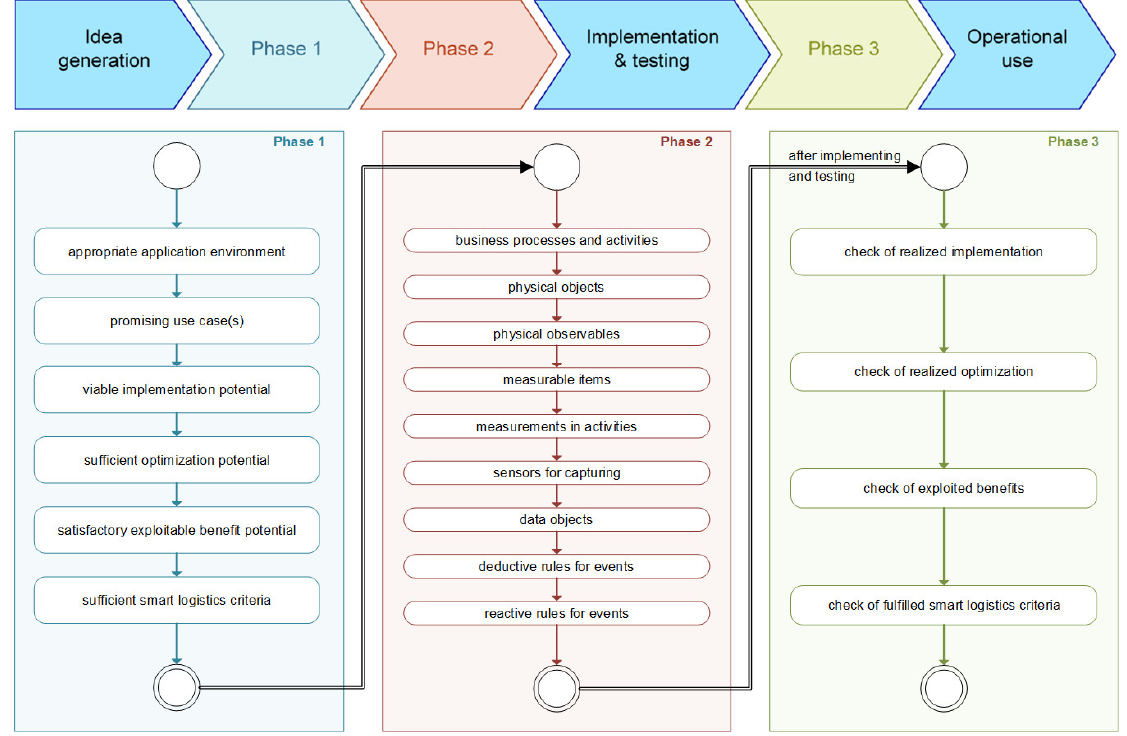
Figure 1. Methodology of realizing smart logistics processes with the help of Cyber-Physical Systems (CPS) and Complex Event Processing (CEP)